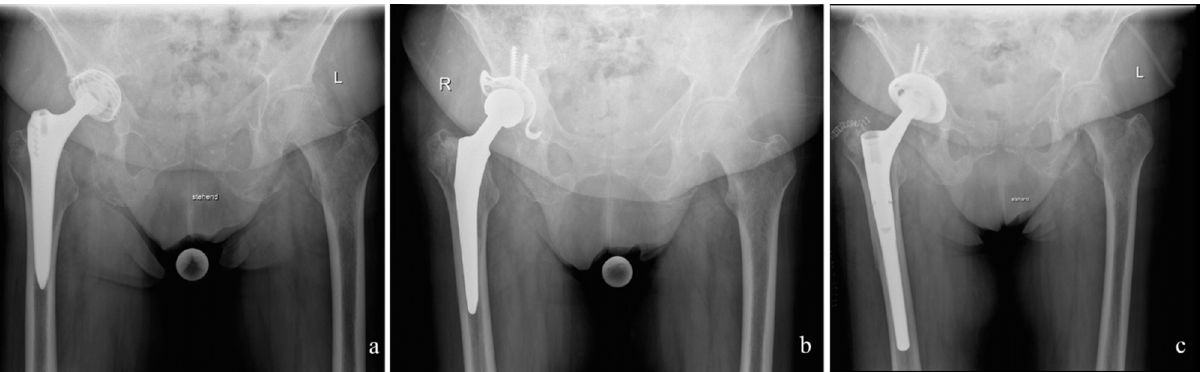
Figure 1. Case with an endofemoral explantation followed by the interim prosthesis and reimplantation. ( a ): Preoperative situation with infected Zweimueller stem. ( b ): After endofemoral explantation of the infected prosthesis, the interim prosthesis was implanted consisting of a cemented stem and acetabular a Ganz-ring with a Müller flat-profile cup (ZimmerBiomet, Winterthur, Switzerland). ( c ): Situation after reimplantation of the definitive prosthesis consisting of Allofit S-cup and Revitan stem (ZimmerBiomet, Winterthur, Switzerland).